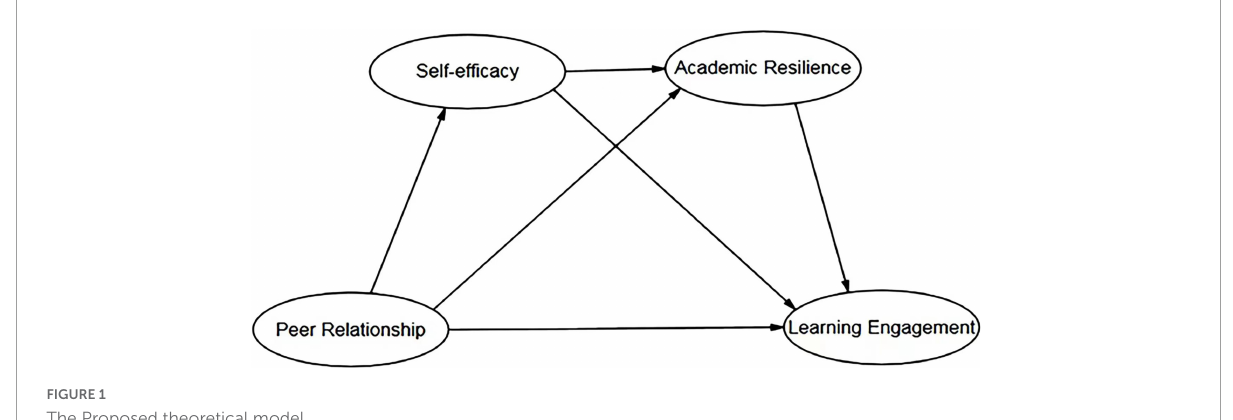
FIGURE1 The Proposed theoretical